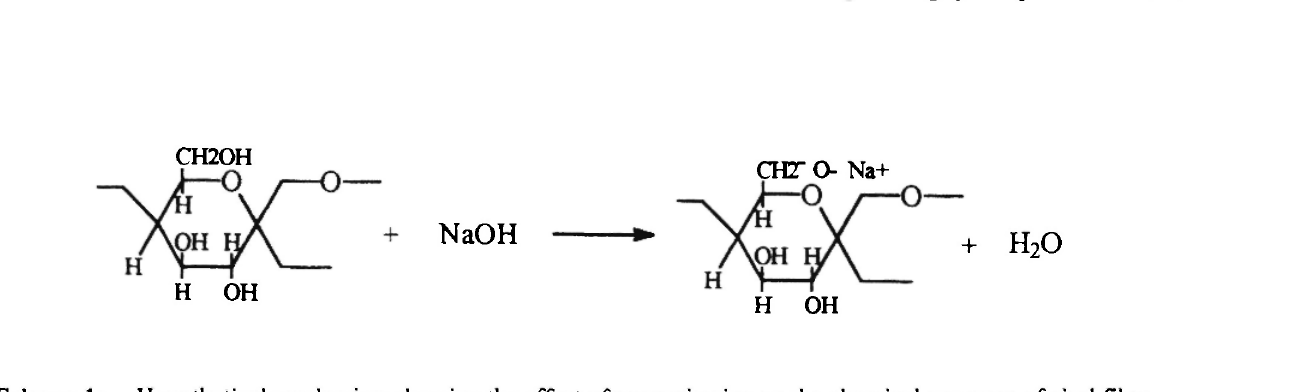
Hypothetical mechanism showing the effect of mercerization on the chemical structure of sisal fibre.